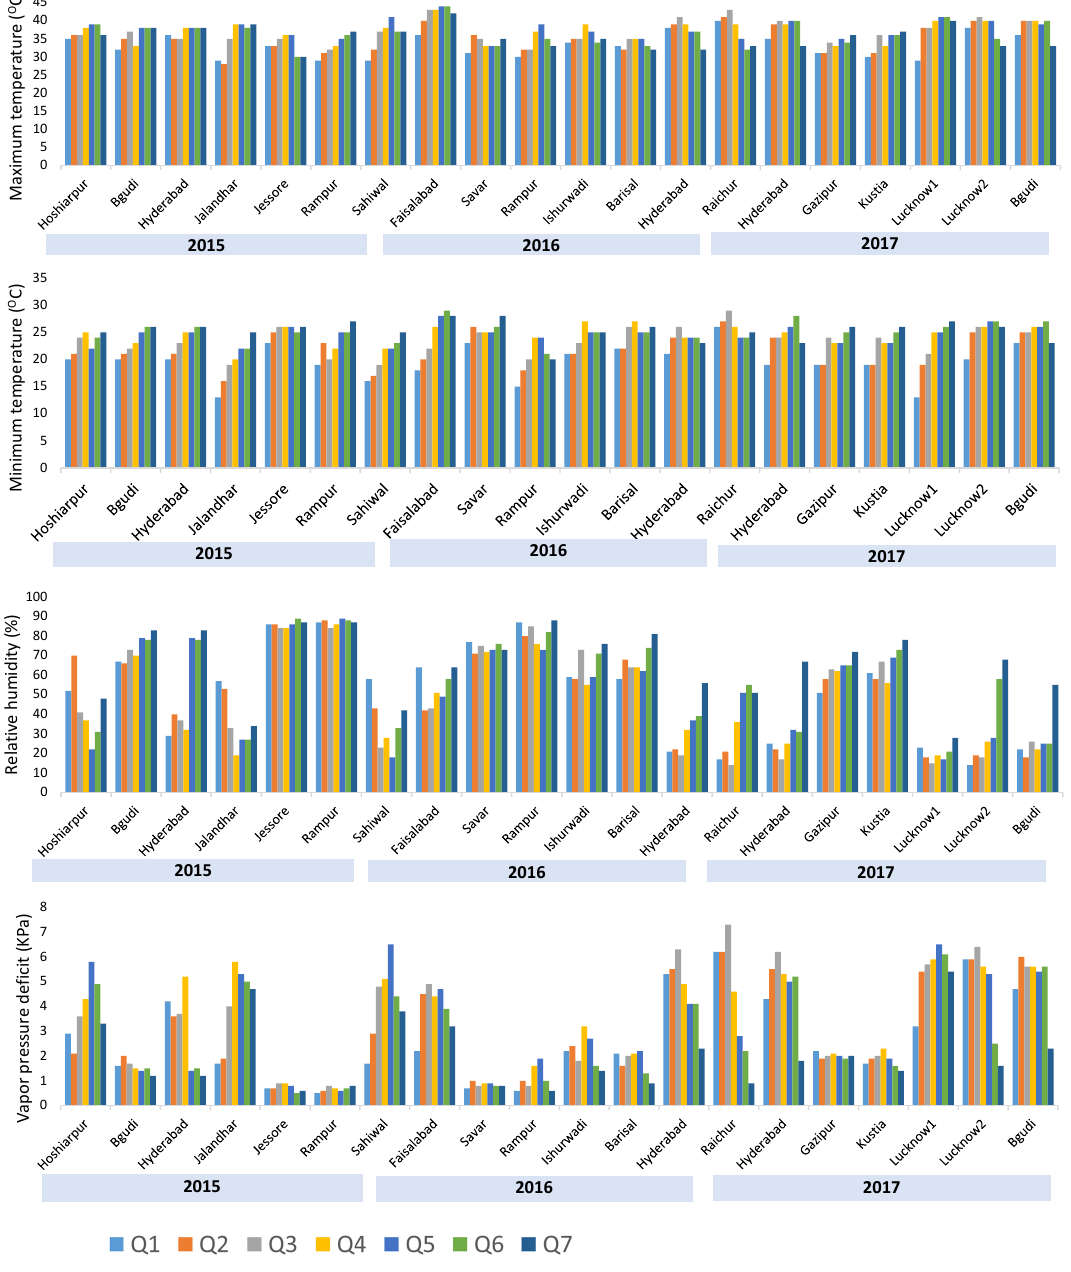
Figure 1. Weather data across di ff erent heat stress environments from 2015 to 2017. Q1 to Q3—vegetative phase, Q4 to Q6—reproductive or flowering phase & Q7—early grain-filling